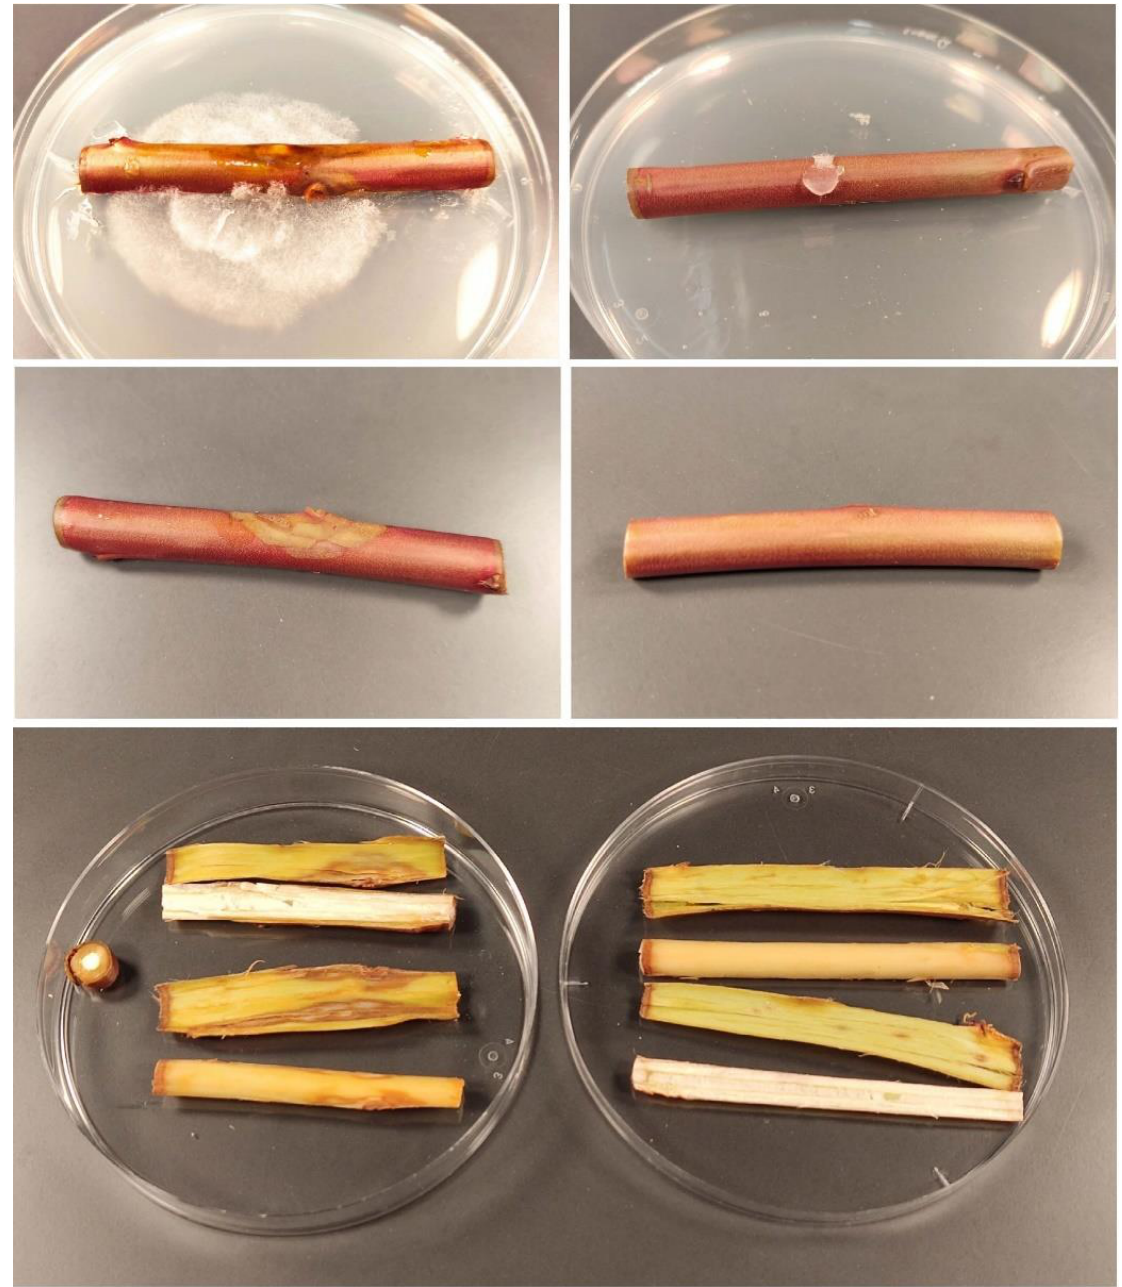
Figure 3. ‘Garnem’ stem segments artificially inoculated with P. cinnamomi after 4 days of incubation: ( left ) untreated samples; ( right ) samples treated with holm oak bark extract at a 782 μg· mL −1 (MIC×10) dose.